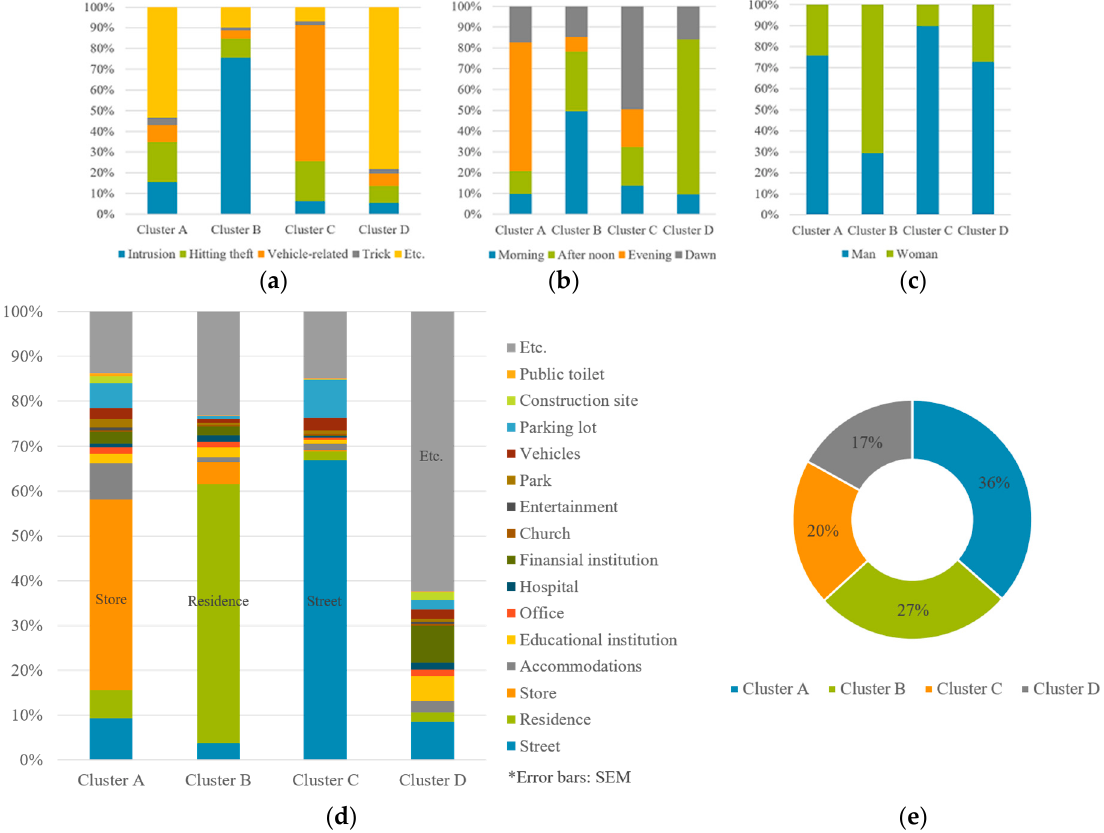
Figure 5. Values by clustering category item; ( a ) Method of crime; ( b ) Time of crime; ( c ) Gender of the victim; ( d ) Location classification; ( e ) Crime rates per clustering.